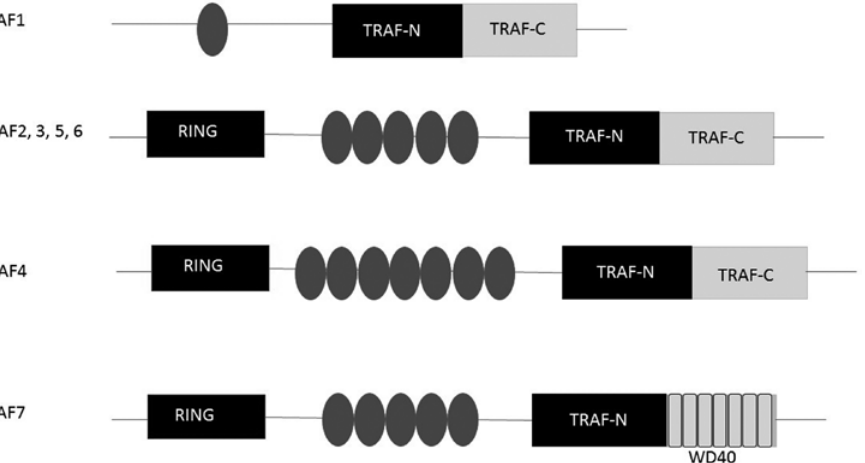
Figure 1: TRAF structures. In the N-terminal, all TRAF members contain a RING-finger domain (RING), except TRAF1. In the C-terminal, all TRAF members have the TRAF domain, divided into TRAF-N and TRAF-C domains. TRAF7 does not contain the TRAF-C domain. Instead, it has seven WD40 domains. Between the N-terminal and C-terminal, all the members contain zinc finger motifs, represented as ovals. The number of zinc fingers is different among TRAF